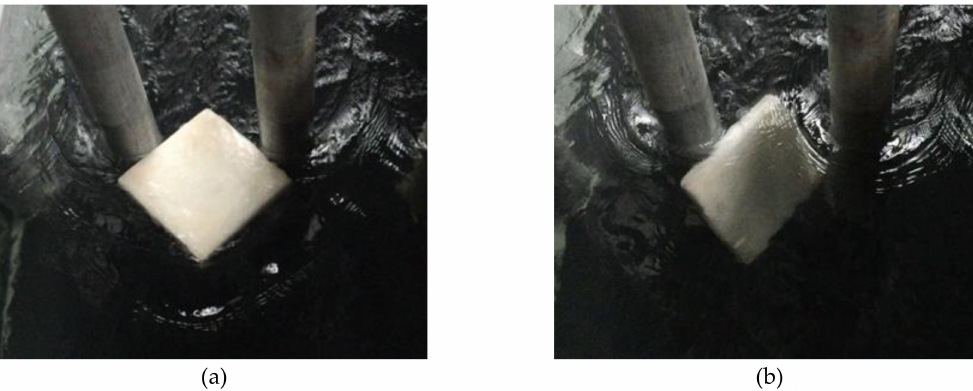
Figure 3. The movement state of the ice block in front of the pier columns: ( a ) Jamming in front of the pier columns; ( b ) Flipping, diving, and passing through the cross-sections between pier